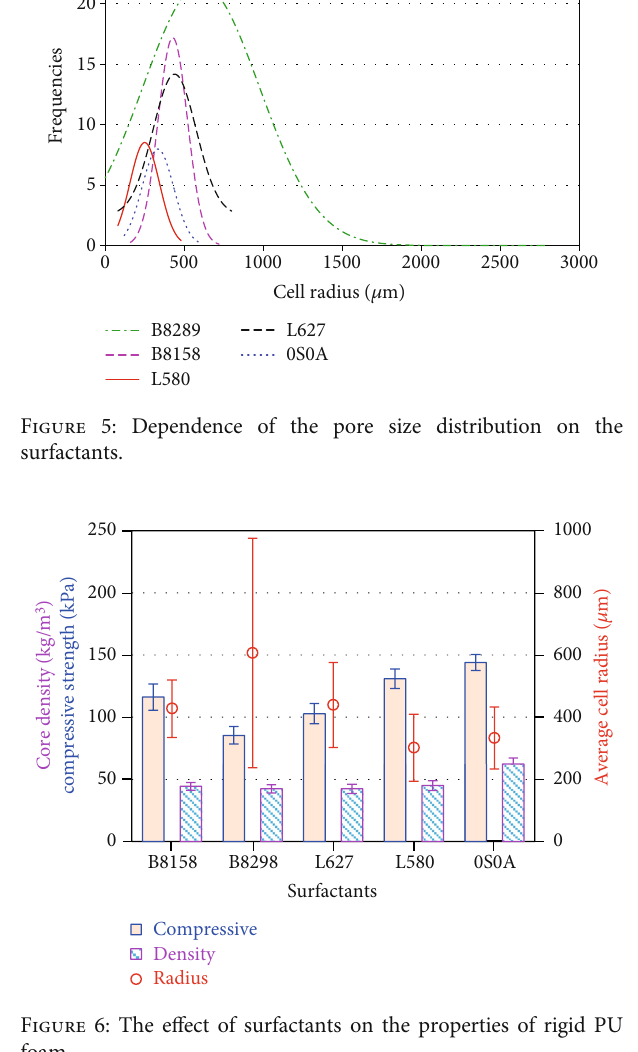
Figure 4: Dependence of the pore size distribution on the silicone and amine content.